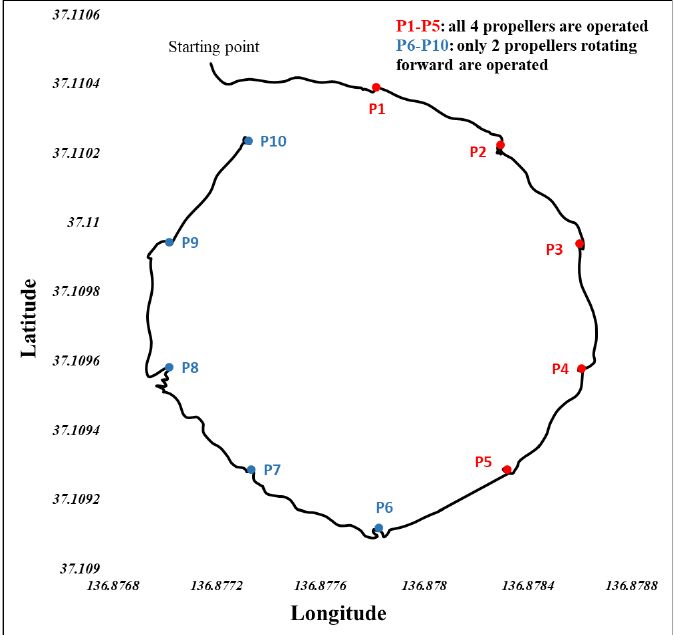
Figure 21. The route of the navigation tests in the actual sea area.